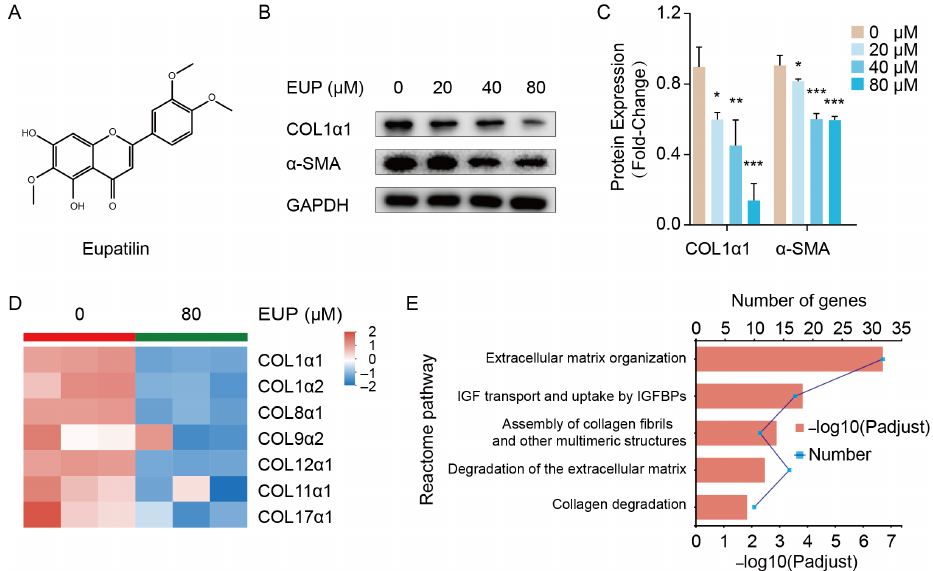
Figure 1. Eupatilin represses the activation of LX-2 cells. ( A ) Chemical structure of eupatilin. ( B ) Protein expression of COL1 α 1, α -SMA detected 48 h after eupatilin treatment by Western blotting. ( C ) Relative protein signal intensity was quantified as mean ± standard deviation (mean ± SD, n = 3). p values are calculated by one-way ANOVA followed by the Tukey’s test. * p < 0.05, ** p < 0.01 and *** p < 0.001 vs. 0 μ M EUP group. ( D ) Heatmap showing expression level of collagens evaluated by transcriptome analysis (n = 3). ( E ) The top five reactome pathways of the DEGs in transcriptome analysis. EUP: Eupatilin; α -SMA: α -smooth muscle actin; COL1 α 1: Collagen type I alpha 1; COL1 α